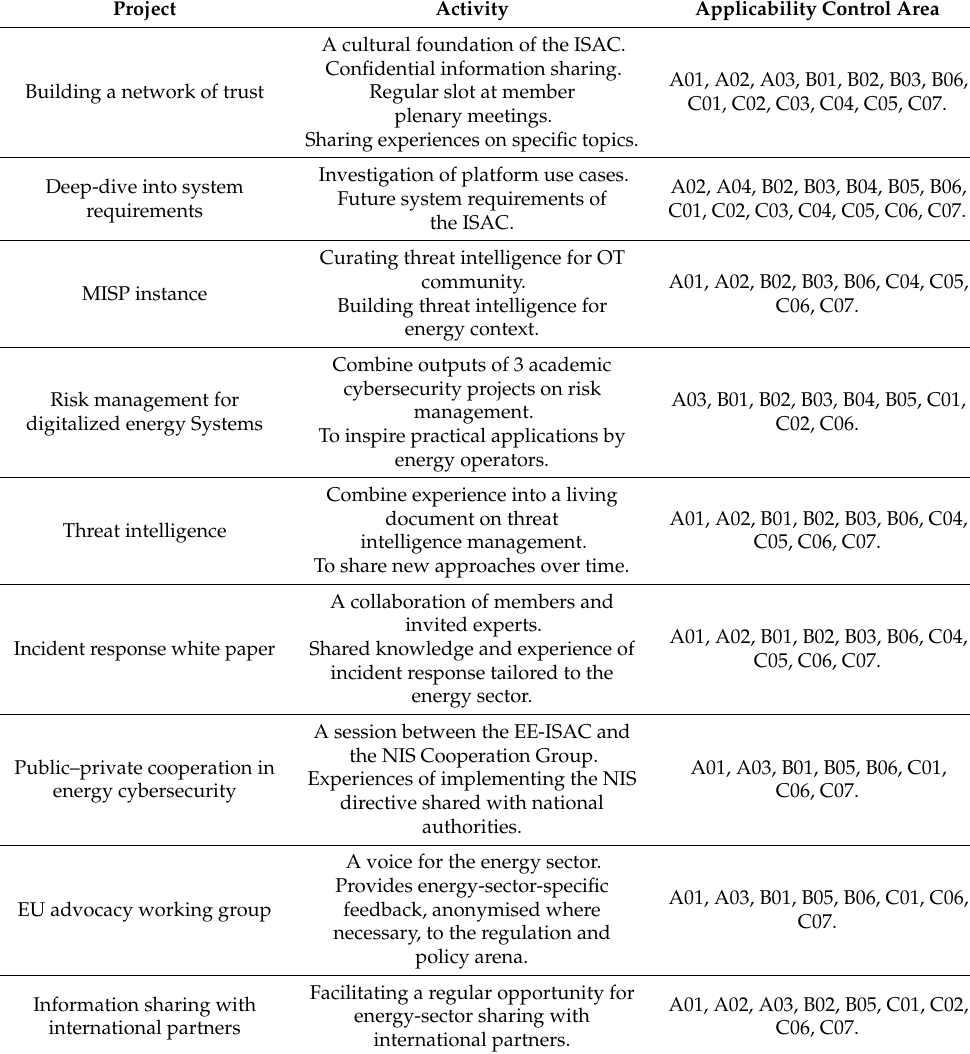
Table 2. Projects performed by EE-ISAC Technical Working Groups and their relevance to applicability control